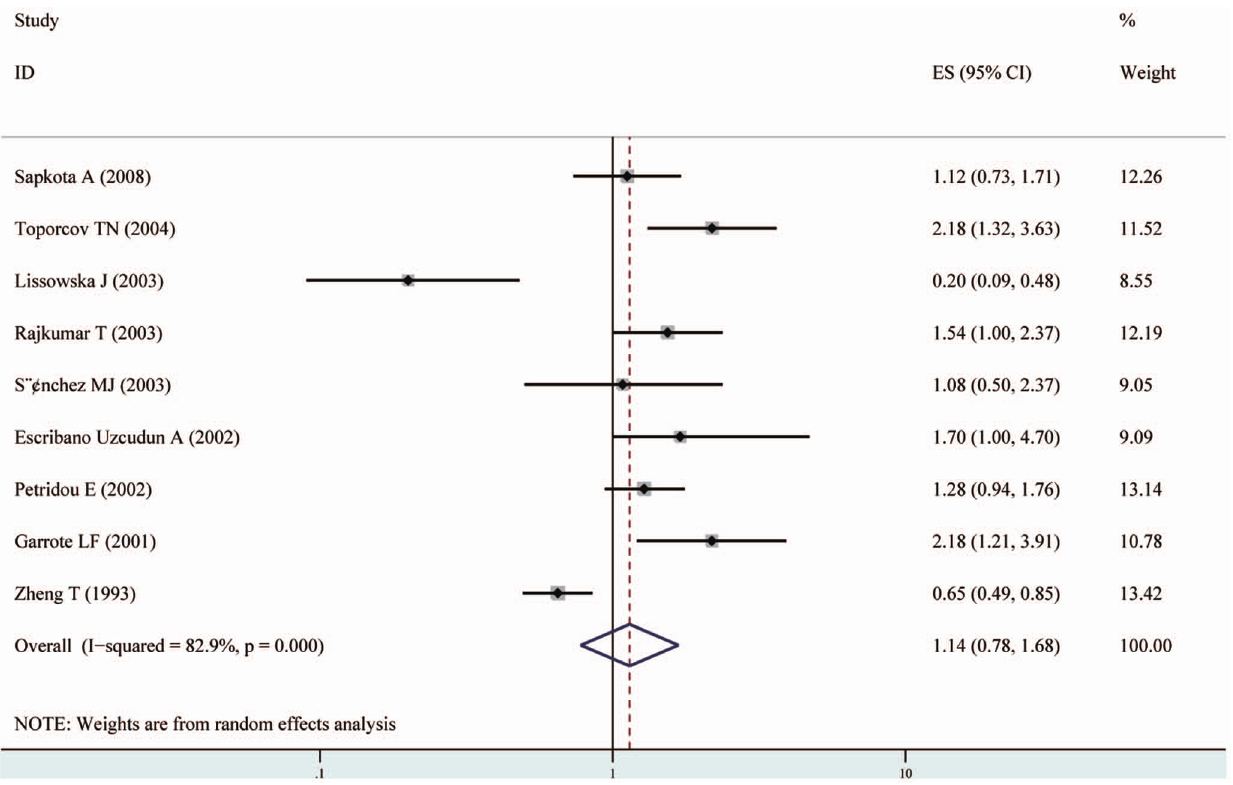
Figure 2. Forest plot: estimates (95% CIs) of total meat consumption and risk of oral cavity and oropharynx cancer. Squares indicated study-specific risk estimates (size of square reflects the study-statistical weight, i.e. inverse of variance); horizontal lines indicate 95% confidence intervals; diamond indicates summary relative risk estimate with its corresponding 95% confidence interval.